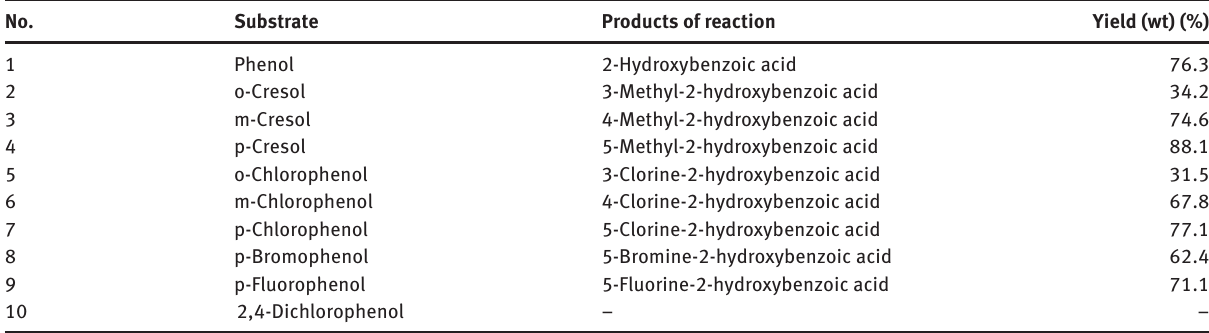
Table 1: Comparative activity of phenol and its derivatives in carboxylation reaction with sodium ethyl carbonate ([substratum] : [sodium = 10 atm, t = 7 h). ethyl carbonate] = 2 : 1, T = 185 ° C, Pco 2 No.